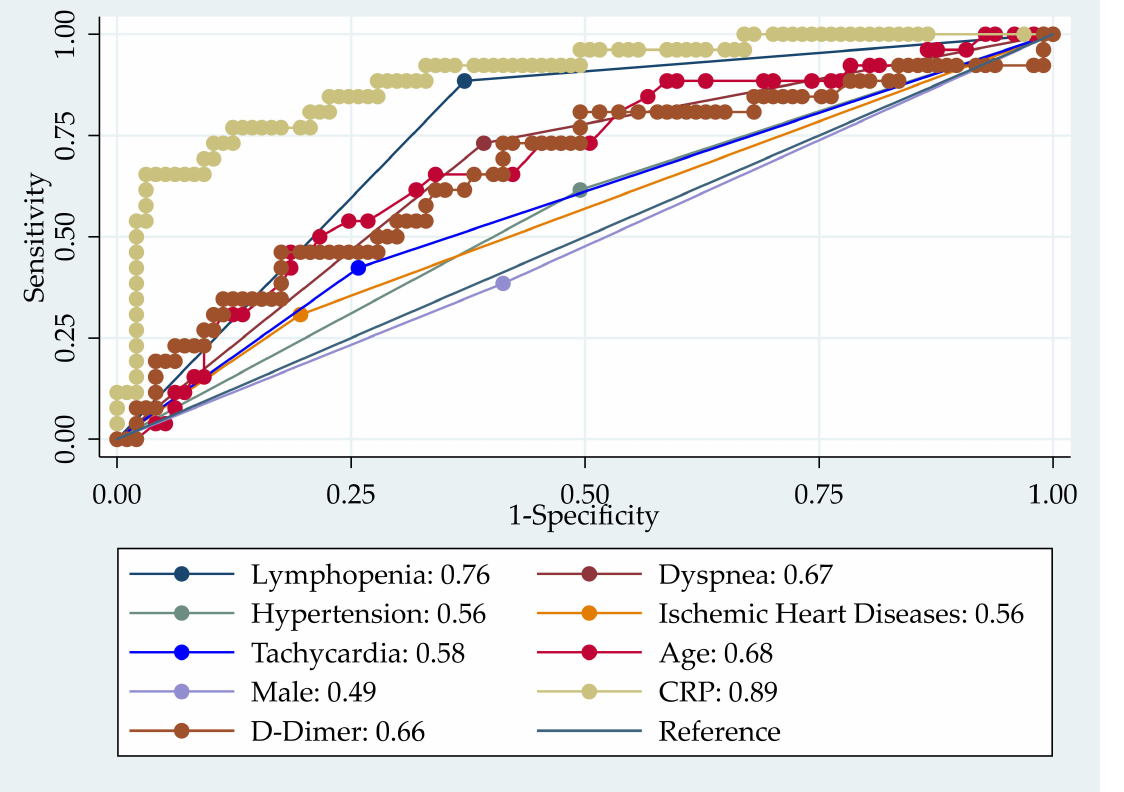
Figure 3. Receiver operating characteristic (ROC) curve with area under the curve (AUC) showing parameters associated with hypoxemia among the patients hospitalized for